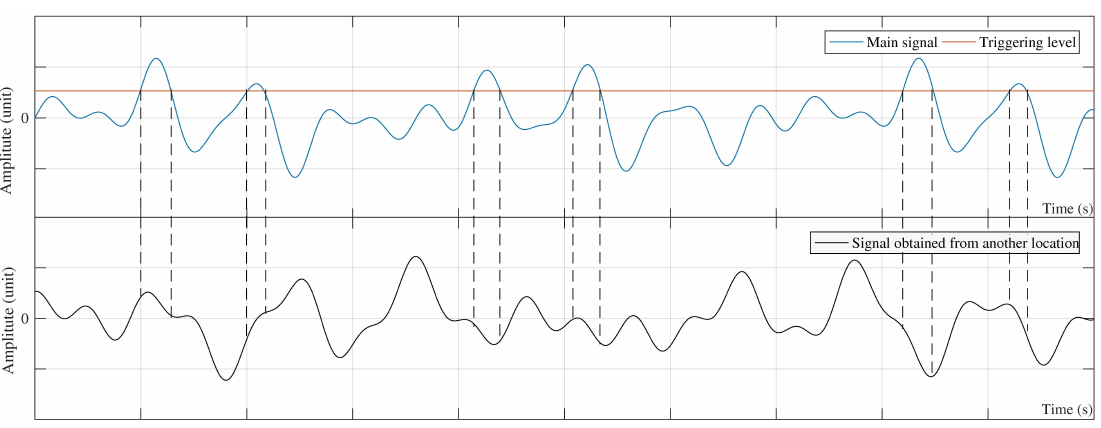
Figure 3. The concept of calculating the cross-RD function.